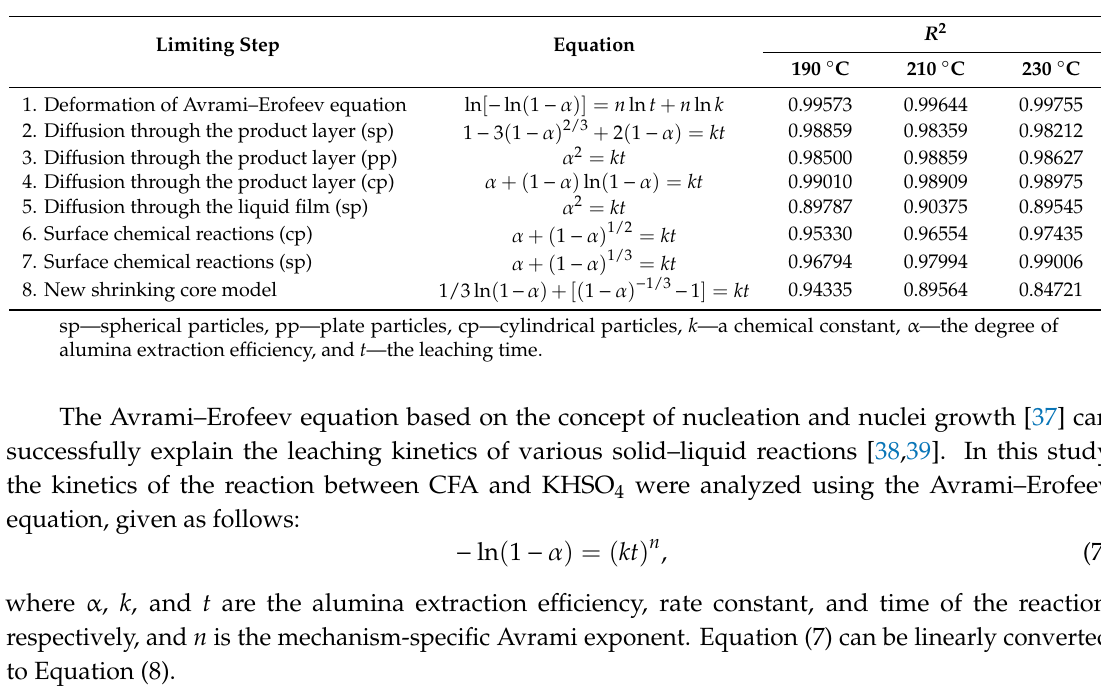
Table 2. Fitting results obtained using several kinetic models.